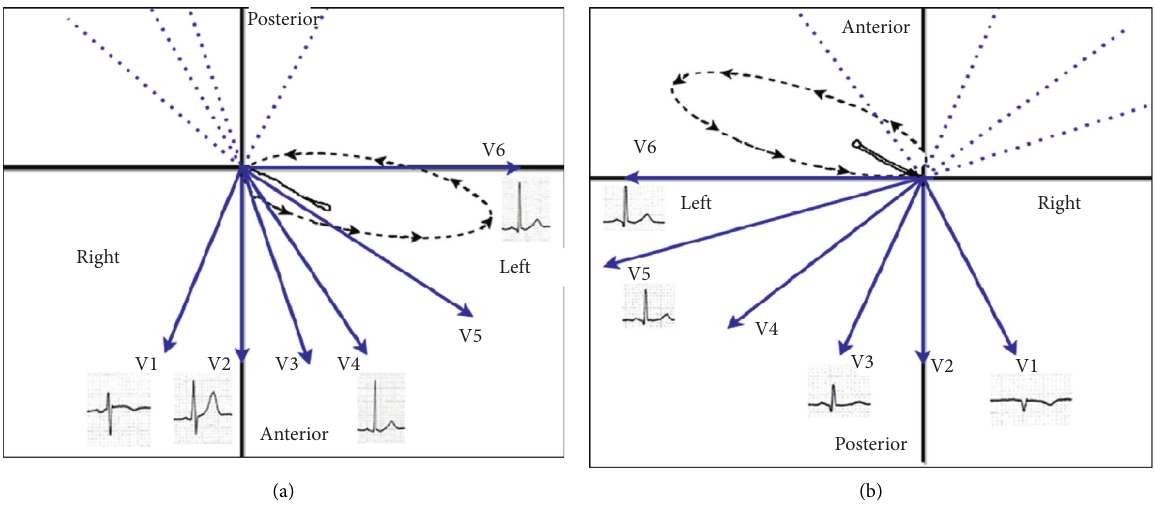
Figure 3: The correlation between QRS vector loops and ECG tracing has been explained. From the centre of the x-y-z axes, QRS waveform circuits are initiated. Sequential 2-ms increments during ventricular depolarization are marked by arrows. On the ECG leads tracing, the amplitude of QRS complexes is consistent with the vertical direction of the vector loop at a specific location and time. (a) In the supine position, the horizontal vector loop showed that, at first, the ventricular depolarization loop was anteriorly and leftward directed towards the anterior chest precordial leads (V1 to V3), resulting in initial positive deflection in these leads. (b) In the prone position, the horizontal vector loop showed that the ventricular depolarization loop was initially oriented anteriorly and leftward away from precordial leads V1 to V3, which are positioned on the back of the patient, resulting in new Q wave emergence and low QRS